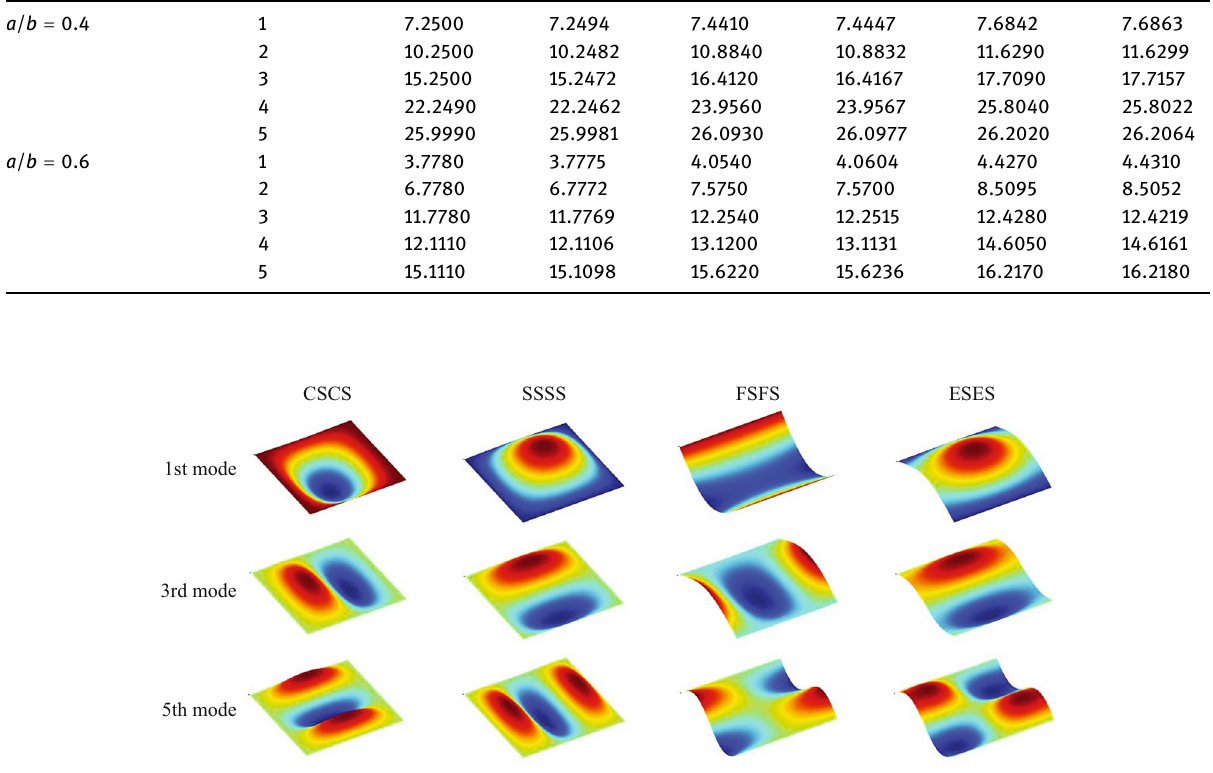
Figure 6: The mode shape of rectangular